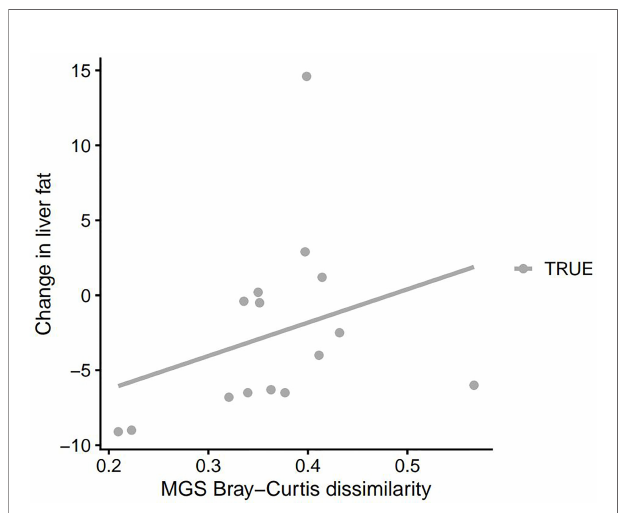
FIGURE 3A | Change in PDFF as a function of MGS Bray-Curtis dissimilarity between faecal samples at baseline and 3 months after DMR. PDFF, proton density fat fraction; MGS, metagenomic species; DMR, duodenal mucosal